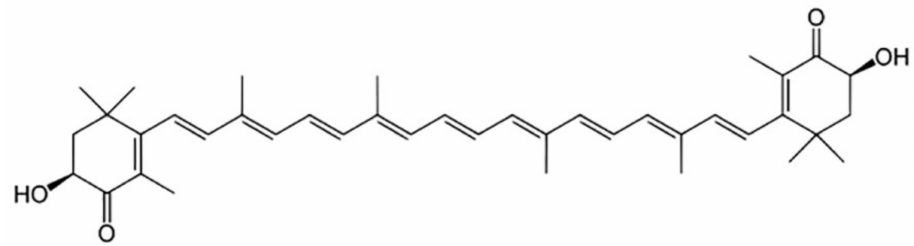
Figure 1. The structure formula of